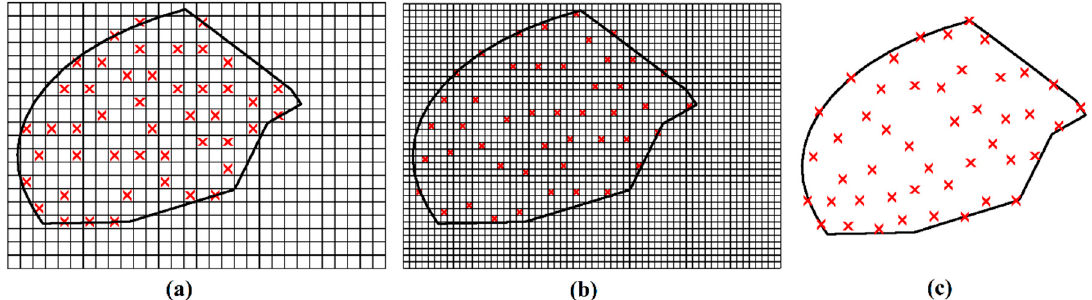
Figure 9. Comparison of optimal wind farm layouts of 46 turbines by: ( a ) 20 × 30 grid method, ( b ) 40 × 60 grid method, and ( c ) coordinate method.